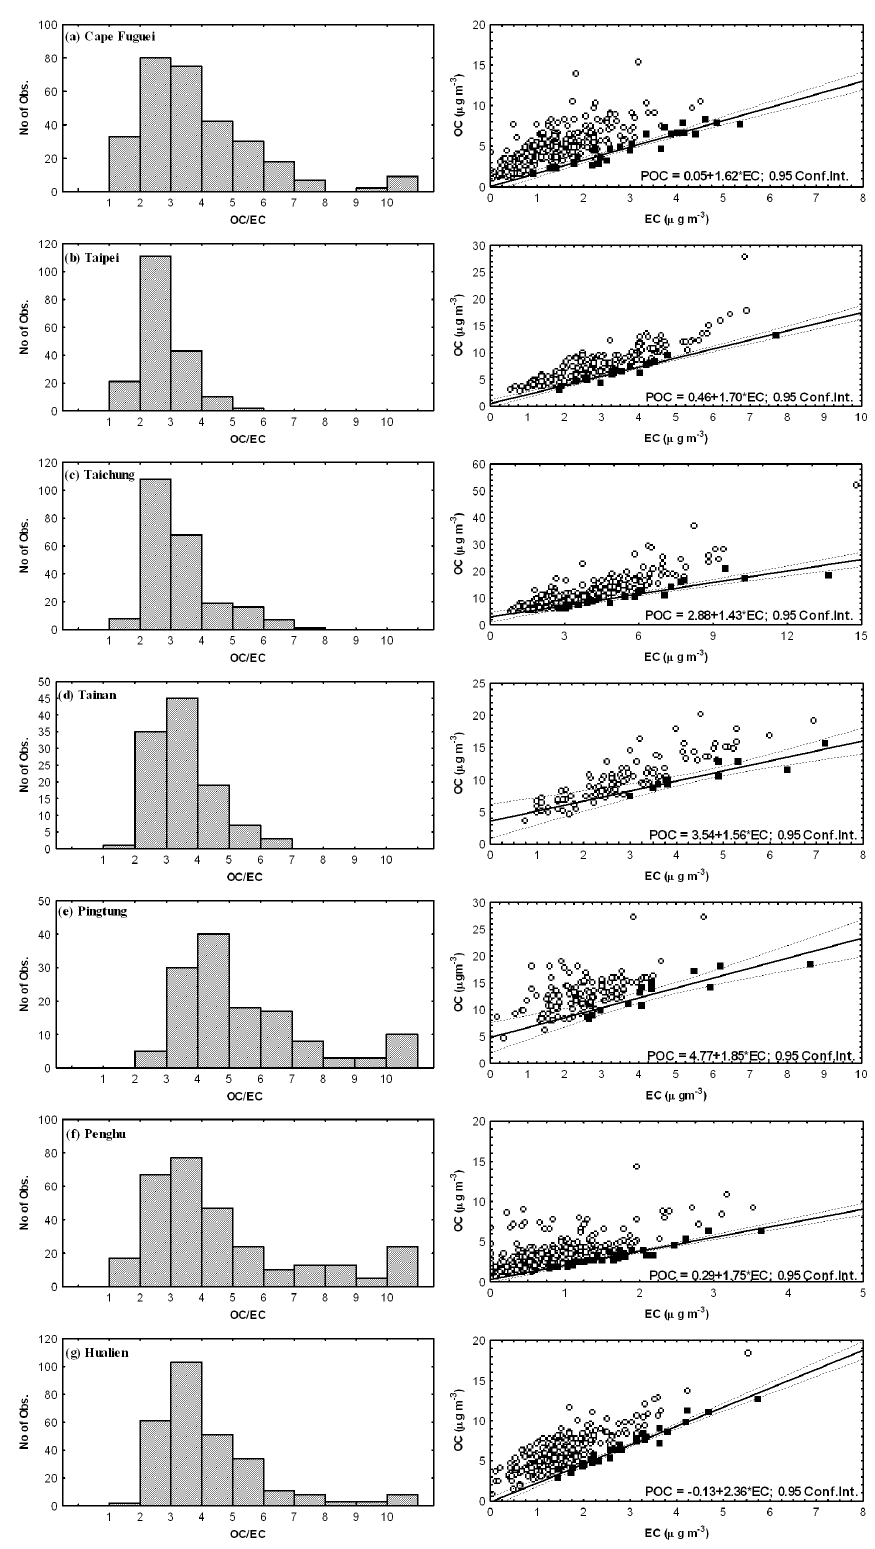
Fig. 2. Histograms of OC/EC ratios and scattering plots of OC vs. EC for PM 10 of respective stations. Data with the lowest 10% OC/EC ratio are shown as solid squares, which were analyzed with linear regression model to derive the site-specific primary OC/EC ratio. www.atmos-chem-phys.net/10/9563/2010/ Atmos. Chem. Phys., 10, 9563–9578,